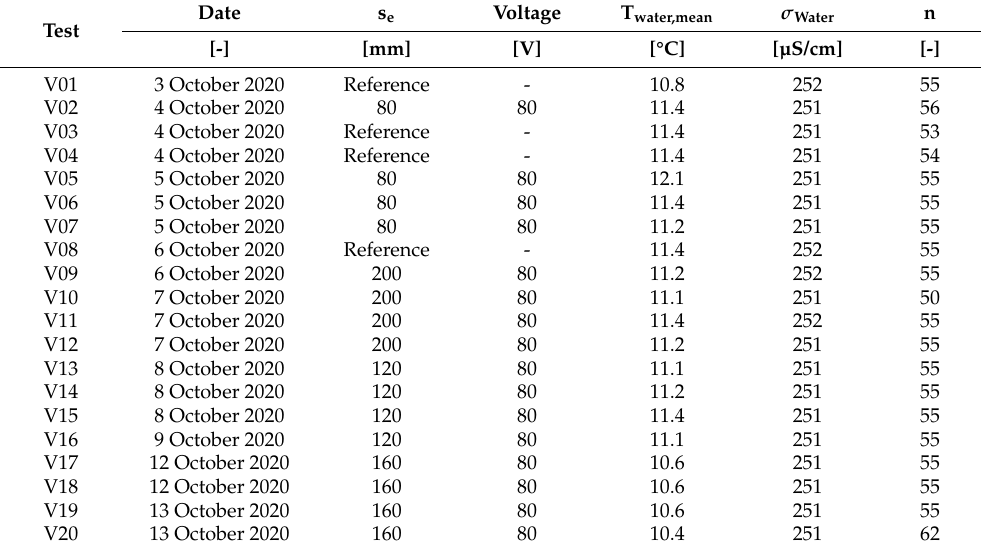
Table A1. Test program for the performed ethohydraulic experiment and main parameters: electrode spacing s e , voltage applied to the electrodes [V], mean water temperature during experiment [°C], σ Water = electrical water conductivity during experiment [µS/cm] and number of individuals participating in the experiment